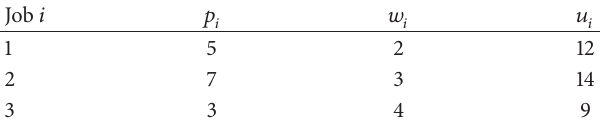
Table 4: Jobs’ parameters in Example